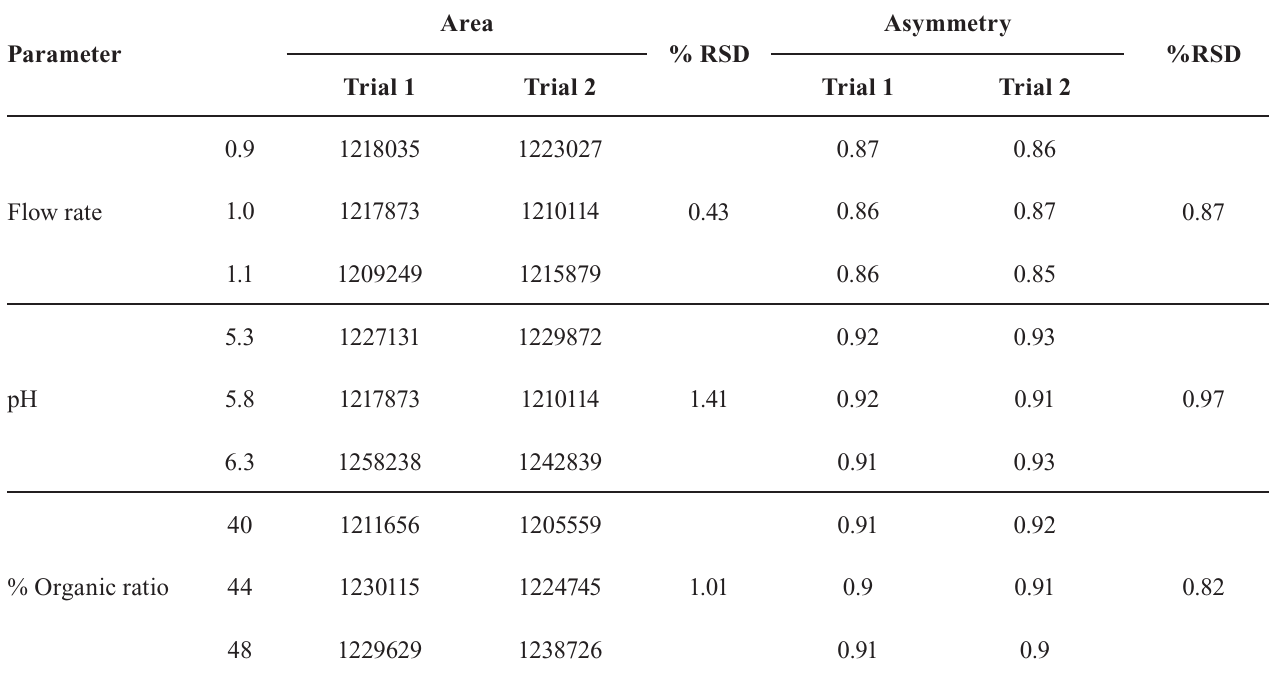
TABLE V- Results of robustness study